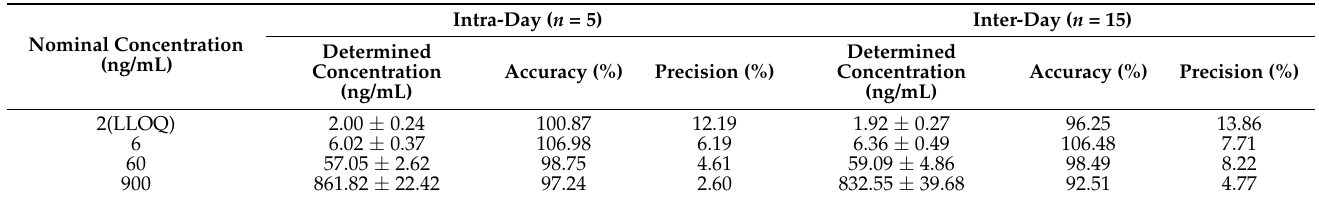
Table 2. Precision and accuracy of oxypeucedanin in rat plasma (intra-day, n = 5; inter-day, n = 15, 3 days).